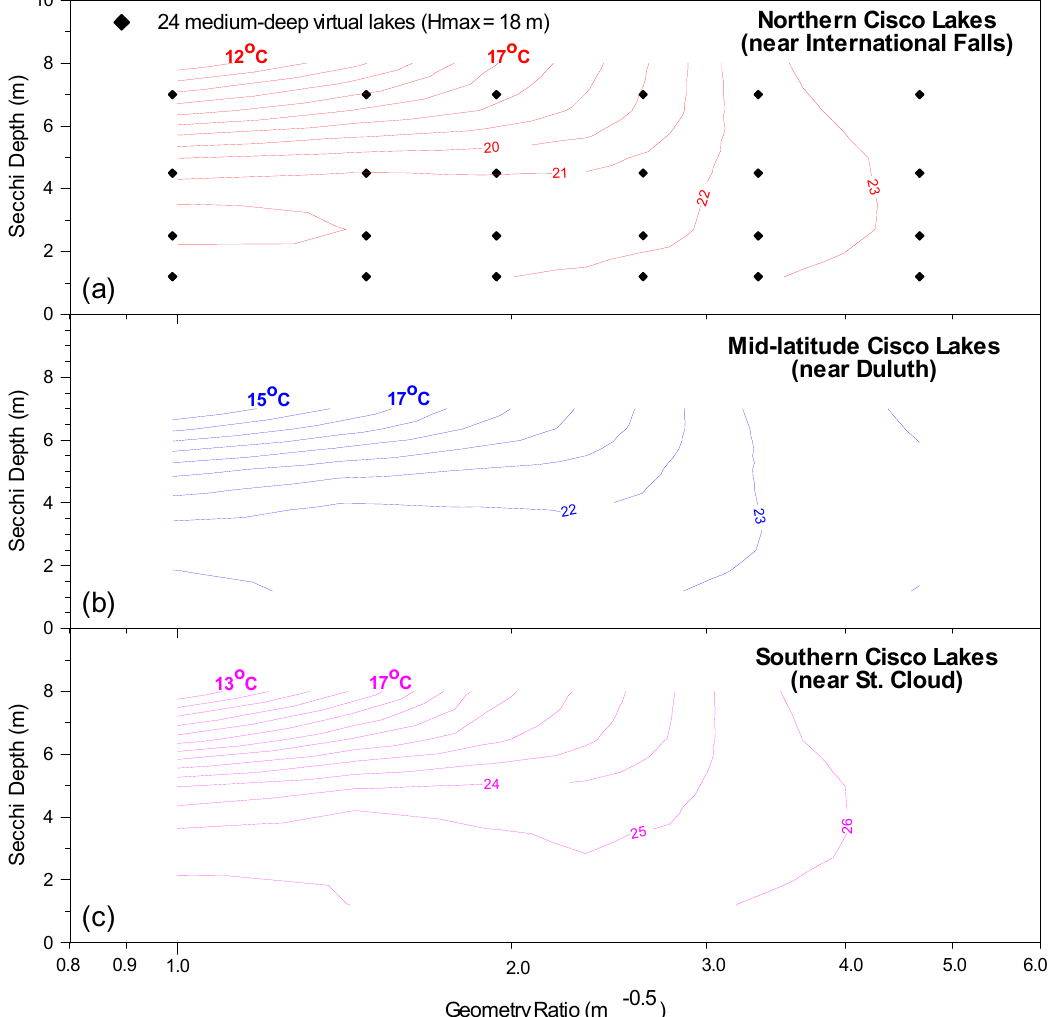
Figure 8. Contour plots of multiyear averages of the highest mean daily TDO3 over variable benchmark periods (i.e., AvgATDO3 VB ) under MIROC 3.2 future climate scenario. ( a ) International Falls, ( b ) Duluth, and ( c ) St. Cloud weather data were used for the model simulations. Contours were derived by interpolation from simulated points for 24 medium-deep virtual lakes.